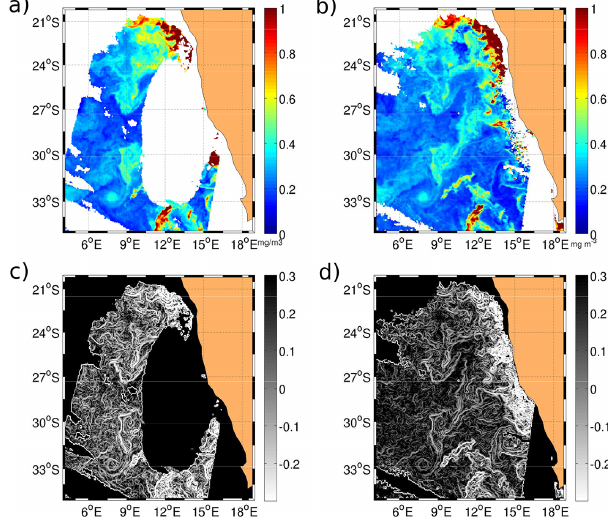
Figure 2. Snapshot of Chl a fields corresponding to 21 Septem- ber 2006, regridded at 1 / 32 ◦ of spatial resolution from MERIS (a) and GSM GLOBCOLOUR (b) . (c) and (d) are the spatial distribu- tion of singularity exponents of the Chl a plotted in (a) and (b) ,